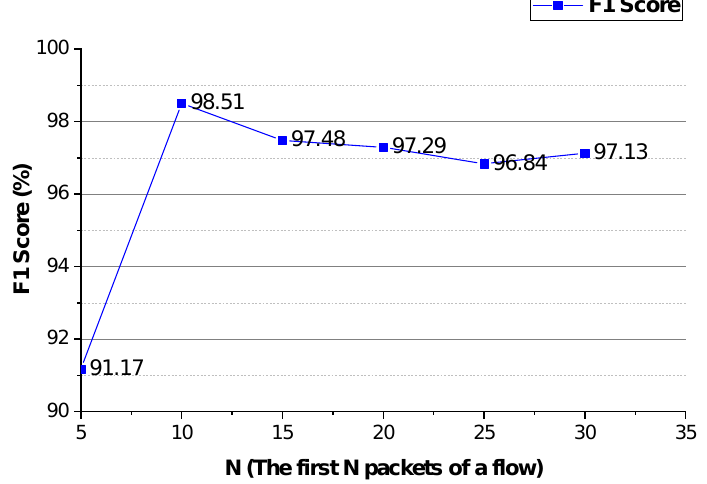
Figure 9. The Shadowsocks traffic detection performance of the method using different N values.